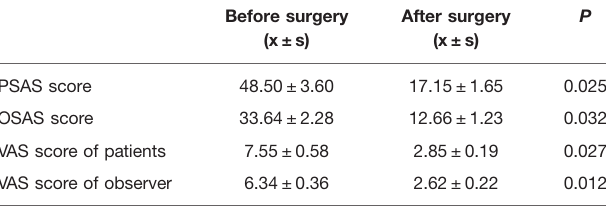
TABLE 1 | Quantitative score of scar before and after surgery ( n =56 cases). Before surgery